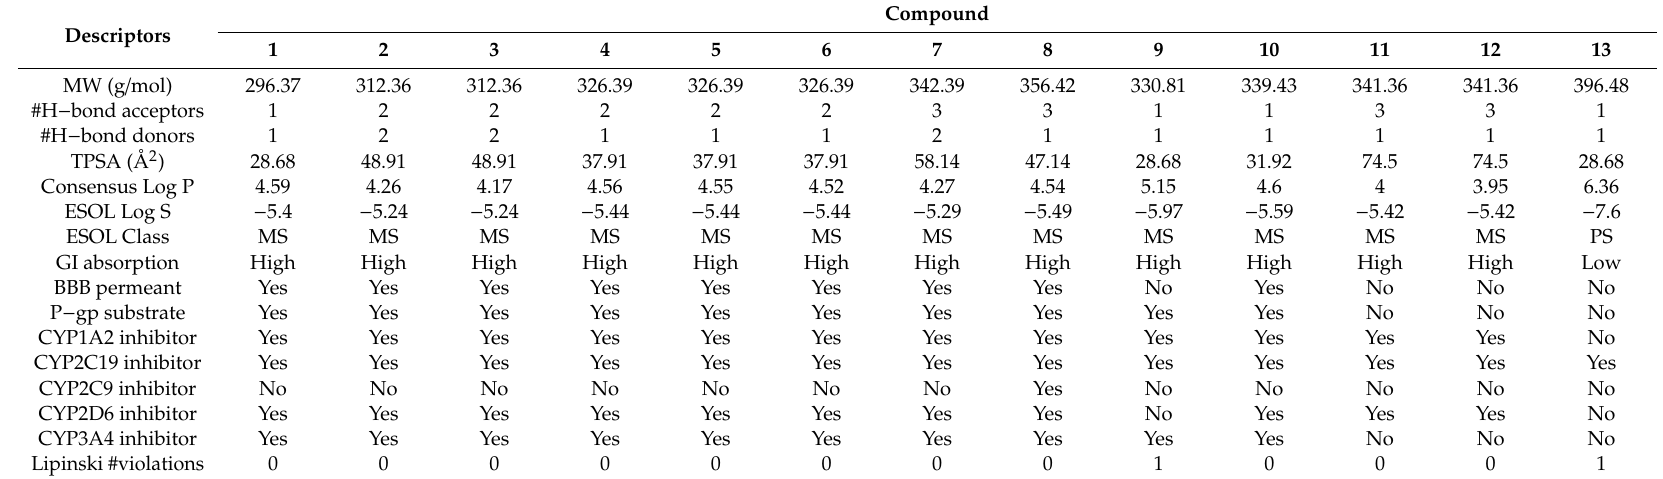
Table 4. Pharmacokinetics and drug-likeness calculations made by SwissADME for the synthesized compounds 1 – 13